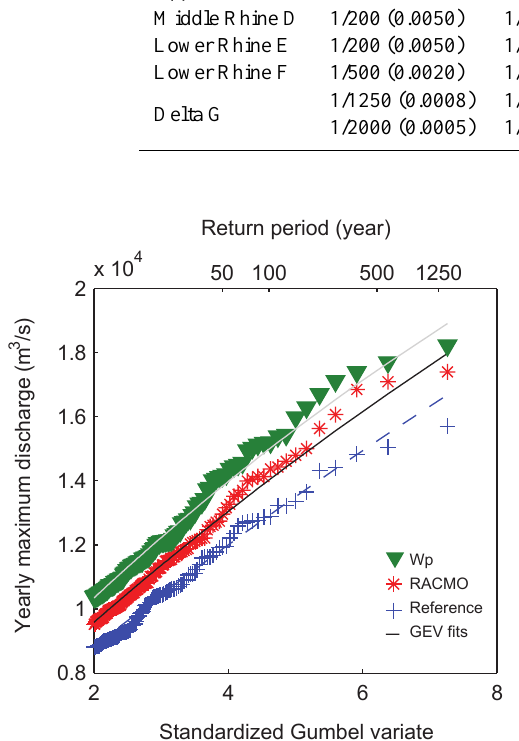
Fig. 3. Extreme value distributions of annual maximum discharge at Lobith, and Generalized Extreme Value (GEV) fits (lines) for the reference situation, and the RACMO and Wp climate change scenarios for the year 2050 (adapted from Te Linde et al., 2010).